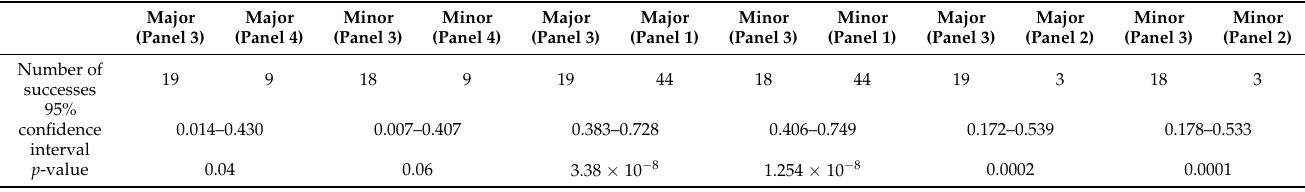
Table 2. Results of the two-tailed Z-tests for the equality of proportions, testing for statistically significant differences in the number of haplotypes phased correctly between each panel in the context of 1:1 mixture